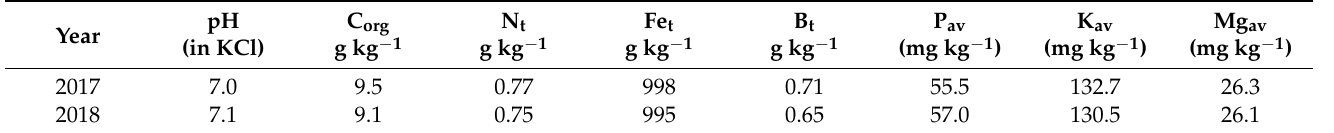
Table 1. Selected soil properties in the layer 0–0.25 m prior to set-up of the experiment in 2017 and